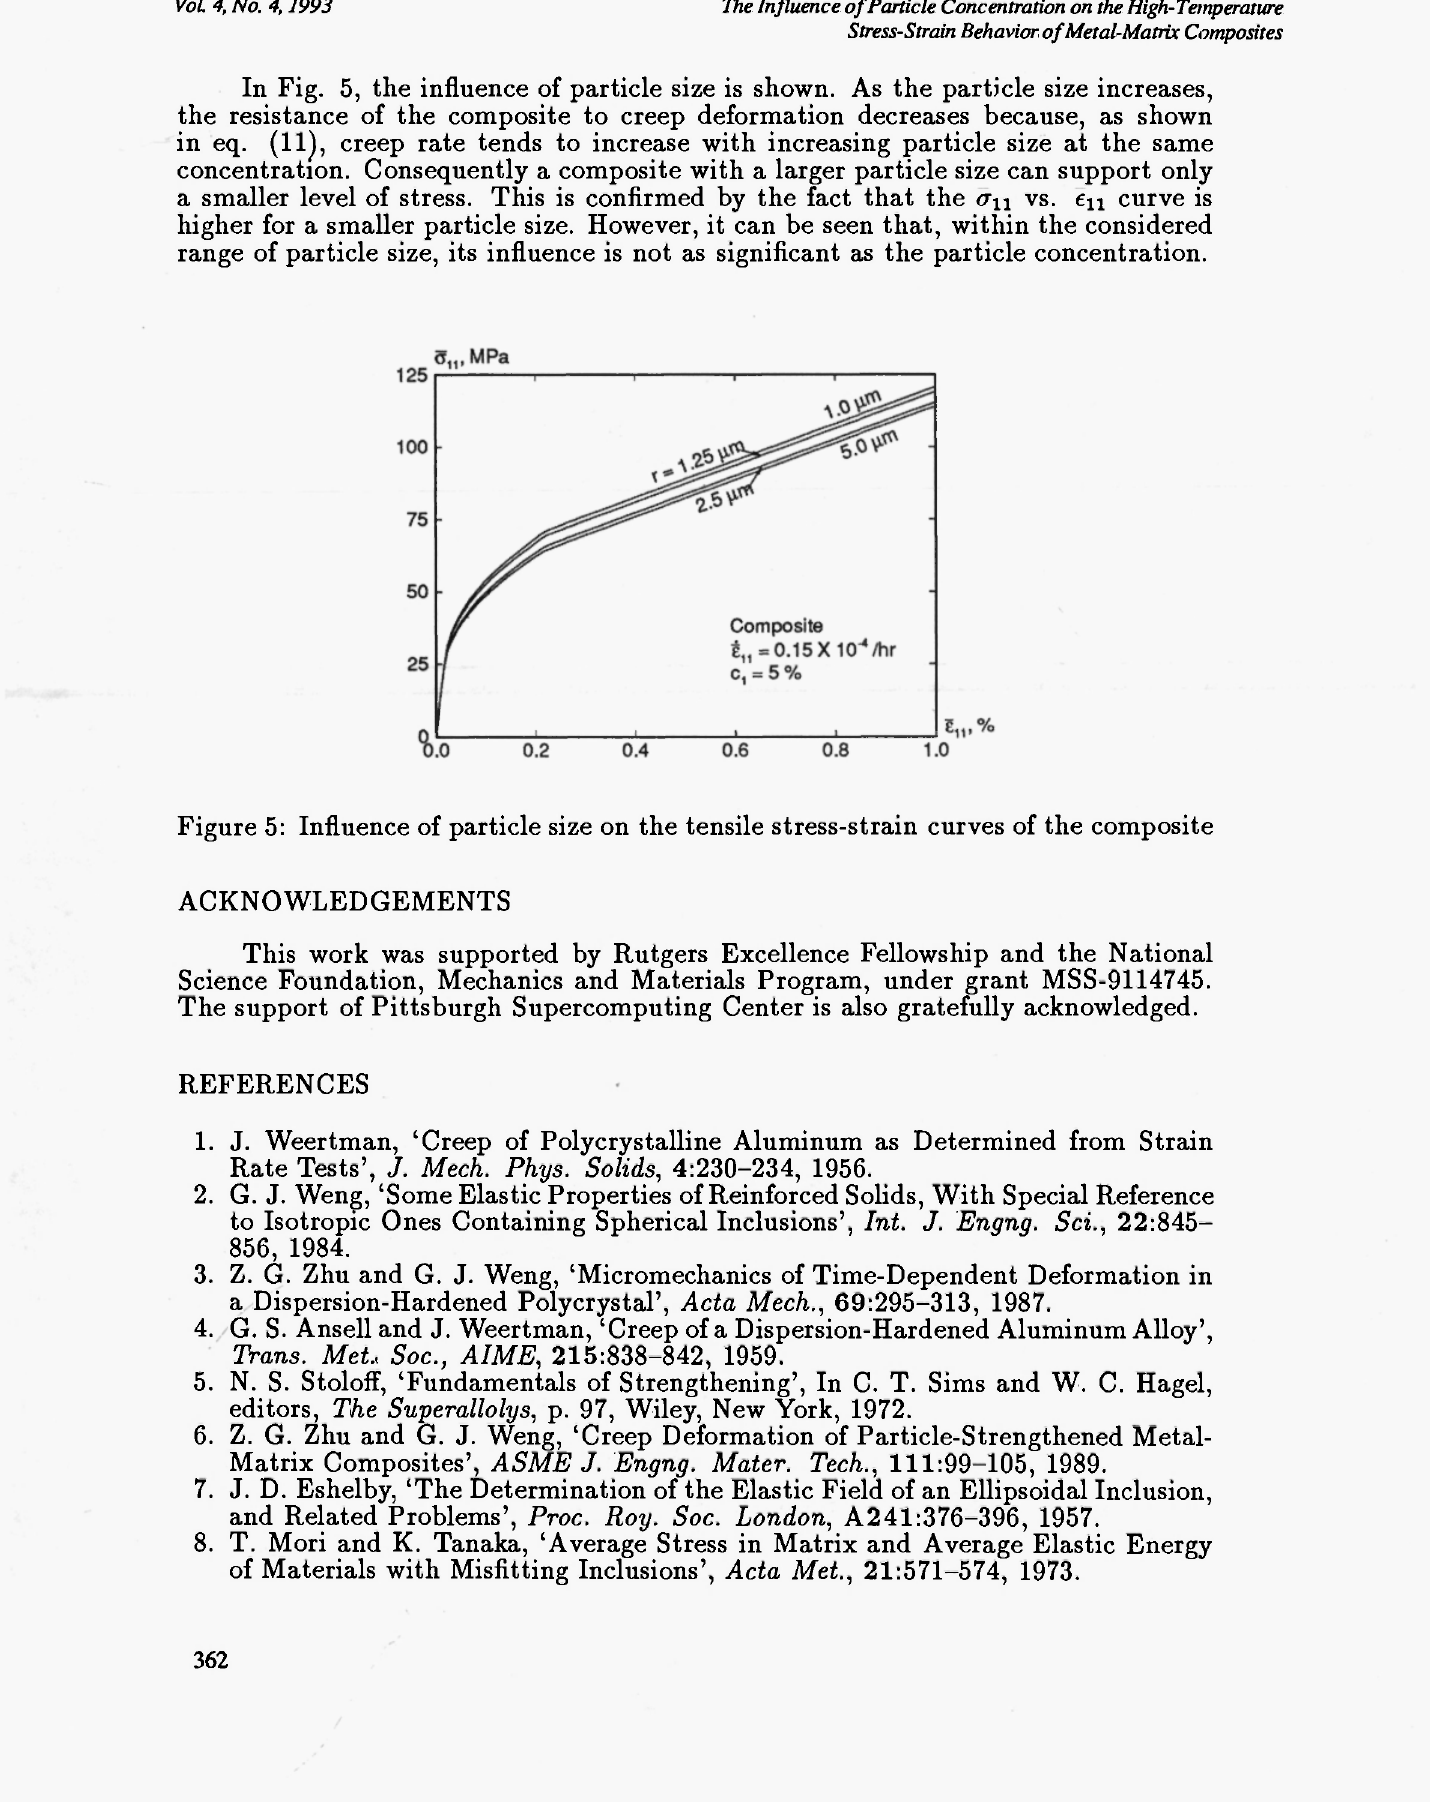
Figure 5: Influence of particle size on the tensile stress-strain curves of the